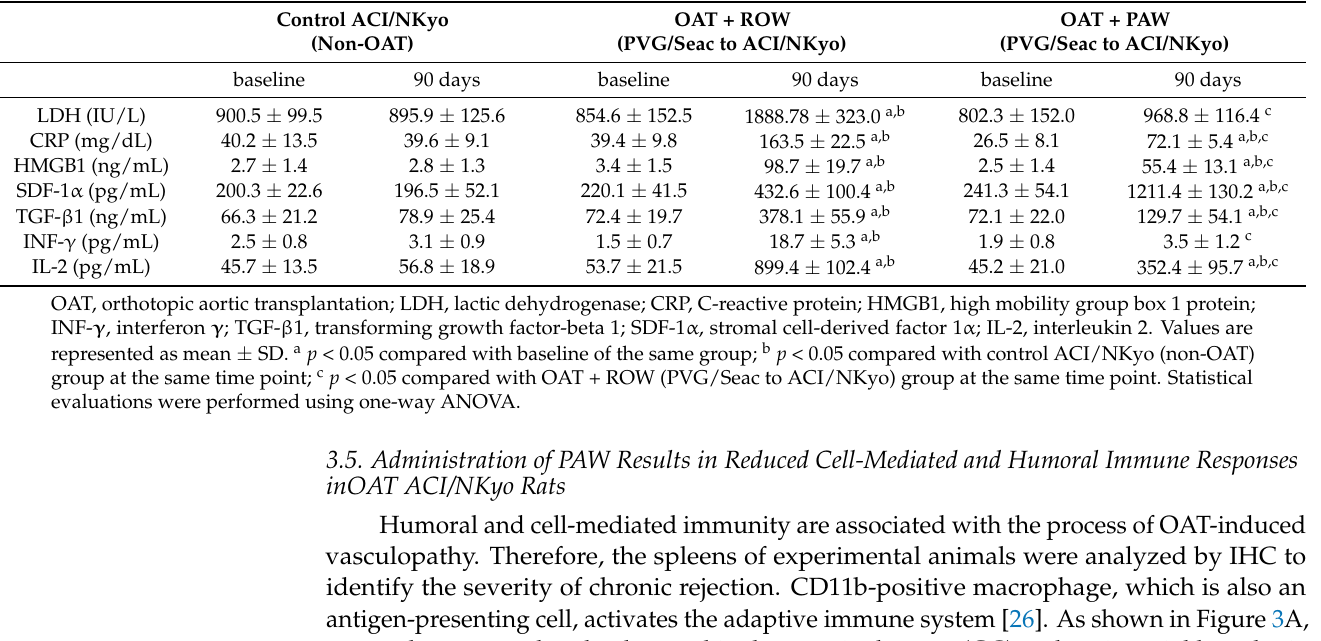
OAT + ROW (PVG/Seac to ACI/NKyo)